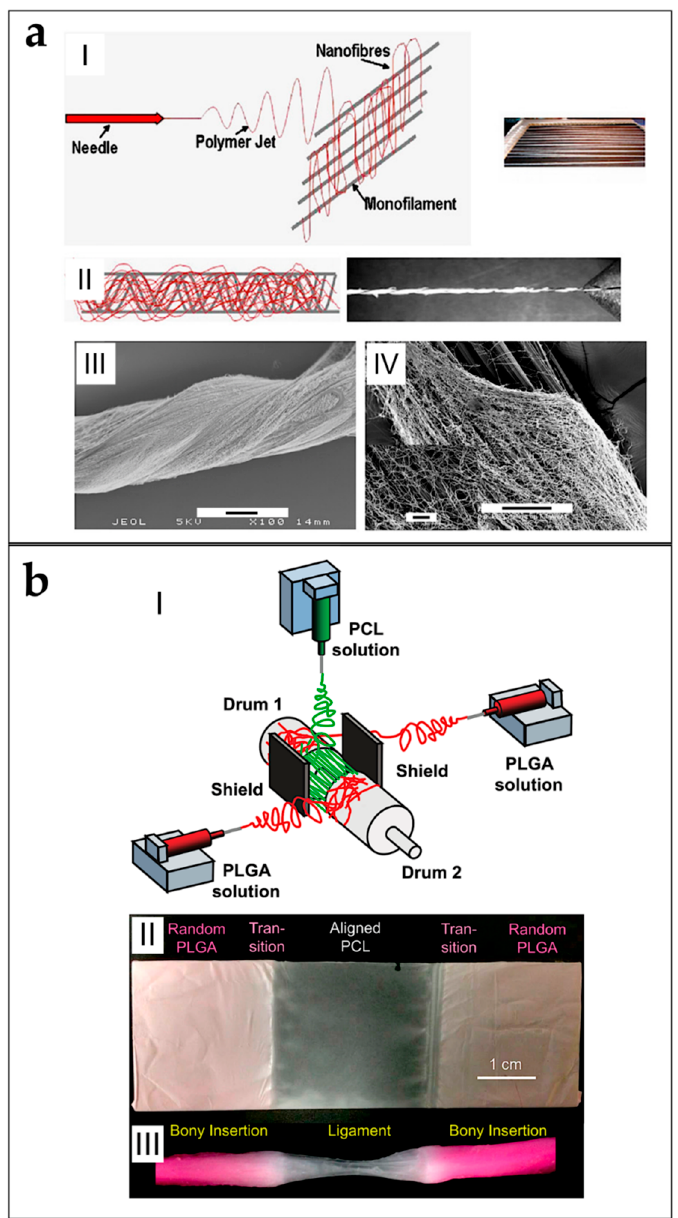
Figure 12. Schematic workflow to produce multiscale hierarchically structured scaffolds for tendon and ligament tissue engineering. ( a ) Microfilaments of PA covered by electrospun nanofibers of PEO, and manually twisted to obtain a scaffold for tendon and ligament applications (adapted from Zhou et al. [122], reproduced with permission. Copyright 2010, Elsevier): (I) the microfilaments are fixed parallel on a rectangular structure, and over pose to a flat plate collector. Then, the nanofibers are electrospun on the microfilaments; (II) after the electrospinning session, the microfilaments are twisted to obtain a tendon/ligament like structure; and (III–IV) SEM images of the scaffold (scale bar III = 100 micrometers; scale bar IV = 100 micrometers, zoom-in = 10 micrometers). ( b ) Combination between air gap collector setup and co-electrospinning of PLLGA and PCL to produce a random/aligned nanofibrous scaffold for ligament tissue regeneration (adapted from Samavedi et al. [87], reproduced with permission. Copyright 2014, John Wiley and Sons): (I) schematic representation of the electrospinning setup; (II) image of the random–aligned–random nanofibrous mat after the removal from the collector; and (III) final scaffold after the wrap of the mat of nanofibers.